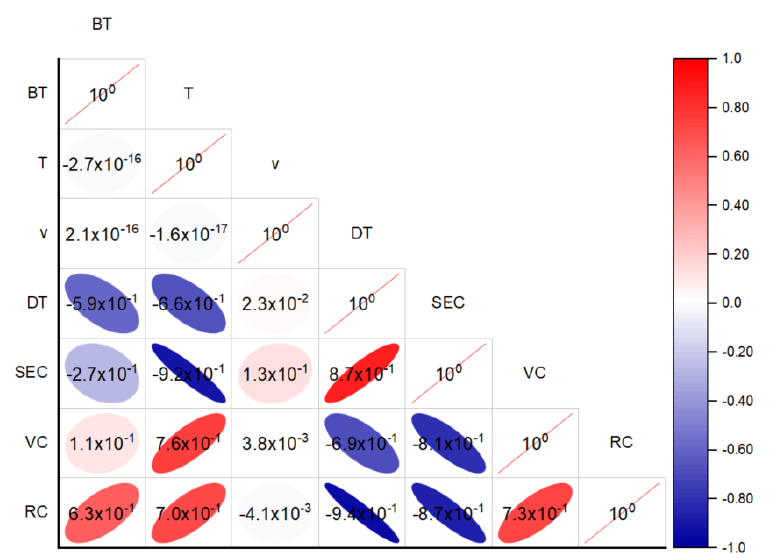
Figure 6. Pearson correlation analysis between different operating parameters and response variables. Note: the numbers in the plots represent the correlation coefficients (r).